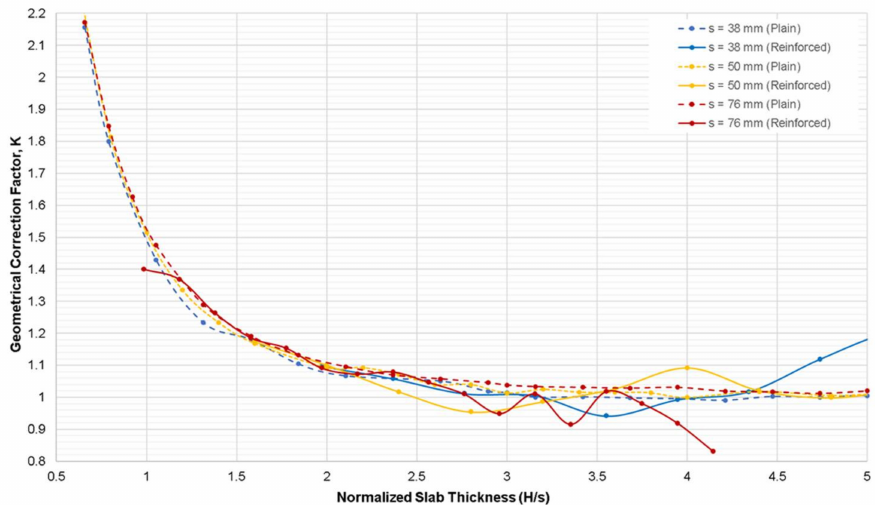
Figure 7. Variation of geometrical correction factor, K , obtained from the numerical simulation case 1 for the reinforced concrete slab model with respect to the normalized slab thickness ( H